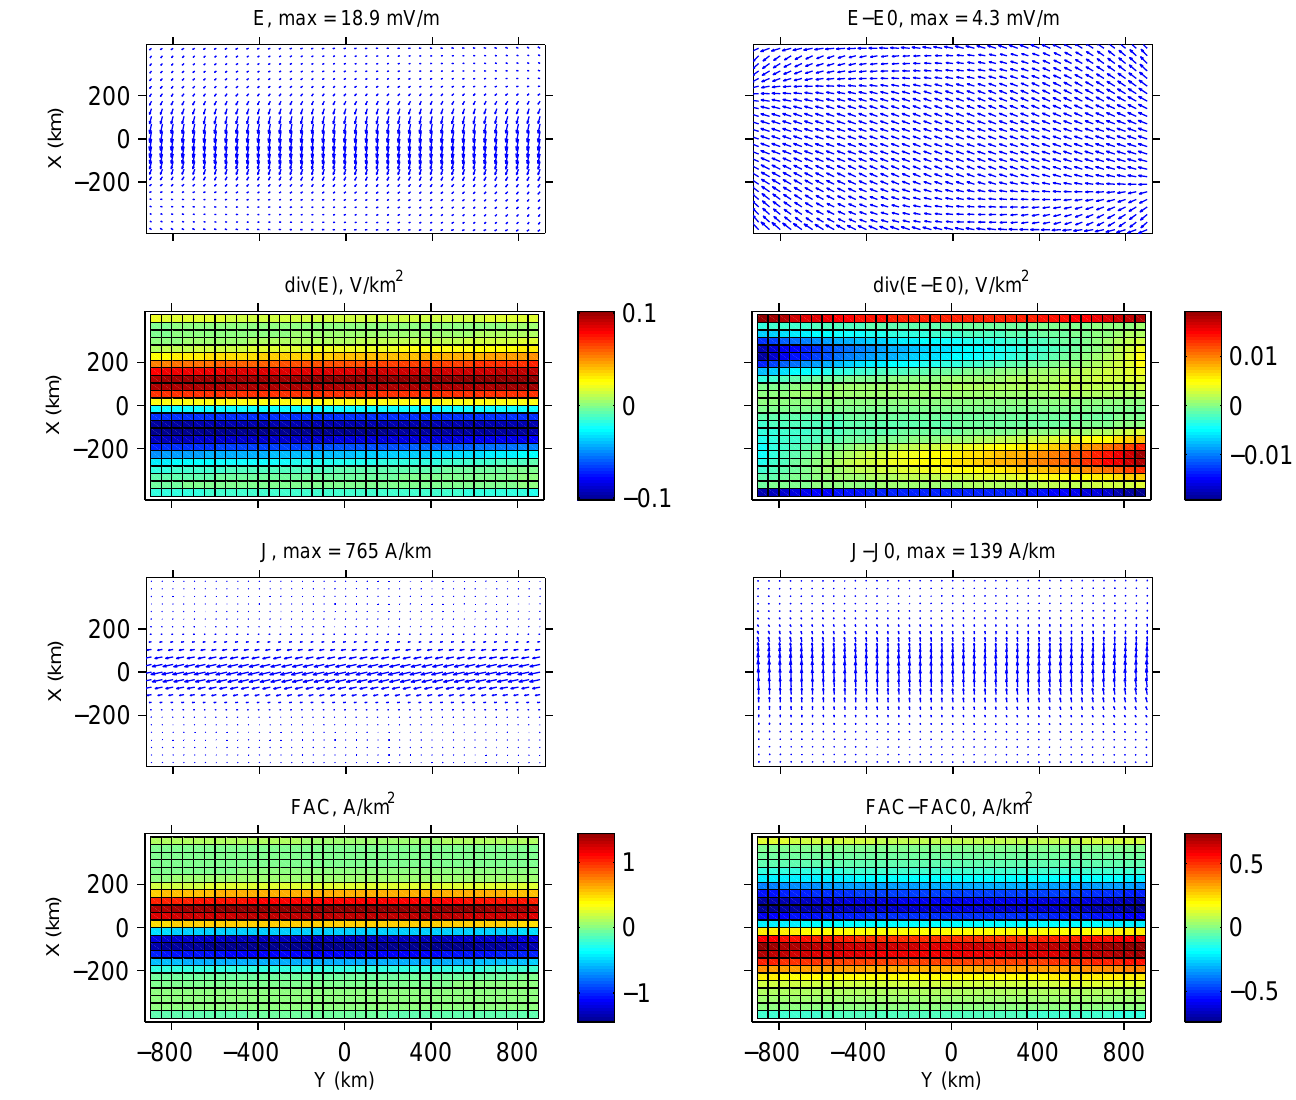
Fig. 4. Results of the CECS method for the electrojet model. Layout is similar to Fig. 3. Note the different scales of the vector plots.